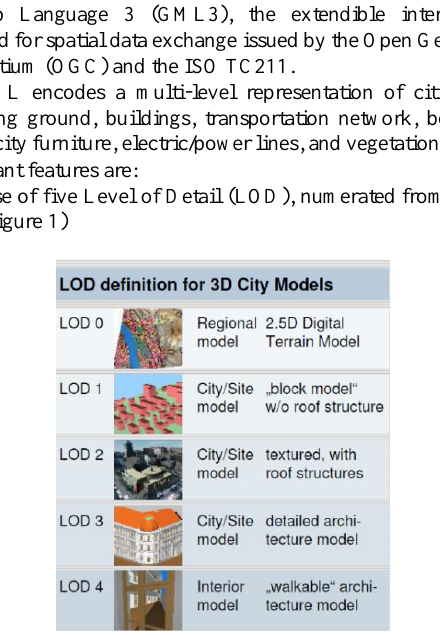
Figure 1. LOD definition (Kolbe et al., 2008)